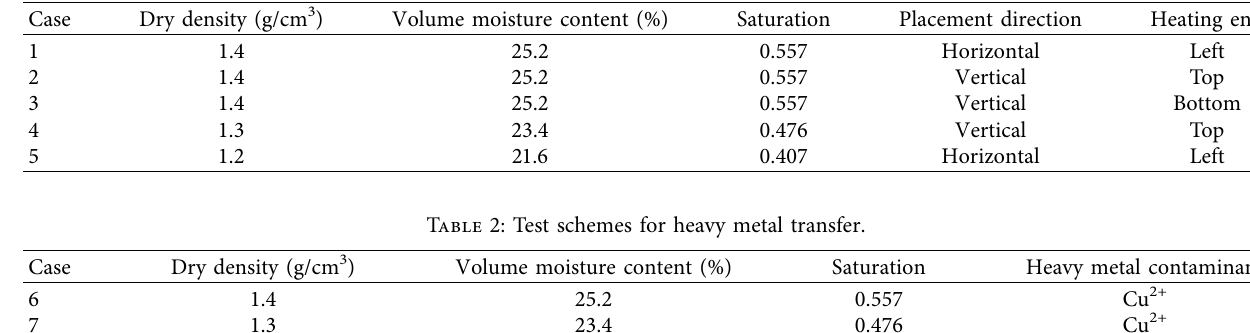
Table 1: Test schemes for cyclic temperature loading.